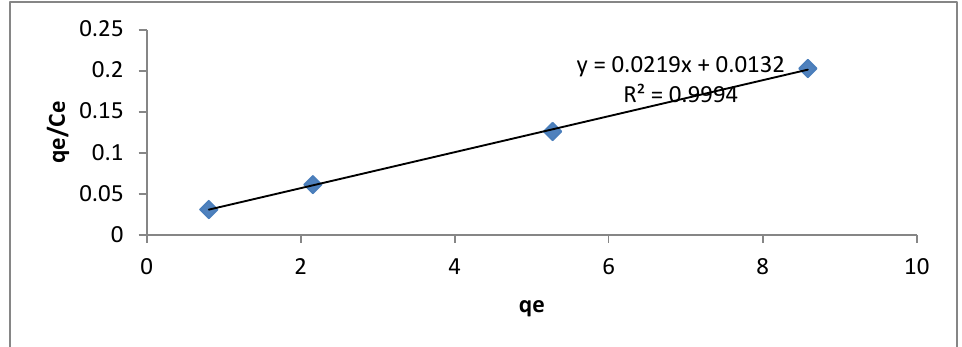
Figure 6: Langmuir isotherm for cadmium removal by unripe banana peel biomass